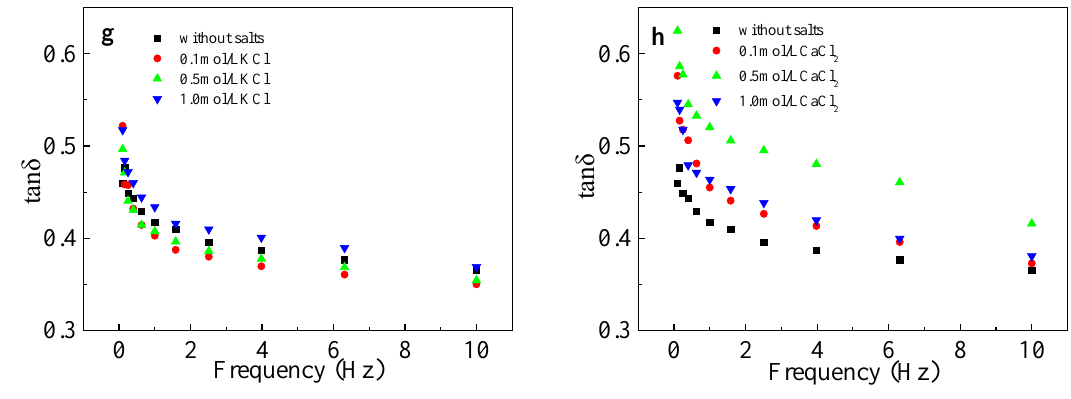
Figure 3. Curves of changes in dynamic modulus and tan δ of LRS/KGM mixtures with frequency in acid or salt solutions. Closed symbols denote the storage modulus ( G ′) and opened symbols denote the loss modulus ( G ″). ( a , b ) acid (citric acid buffer); ( c , f ) NaCl; ( d , g ) KCl; ( e , h ) CaCl 2 .